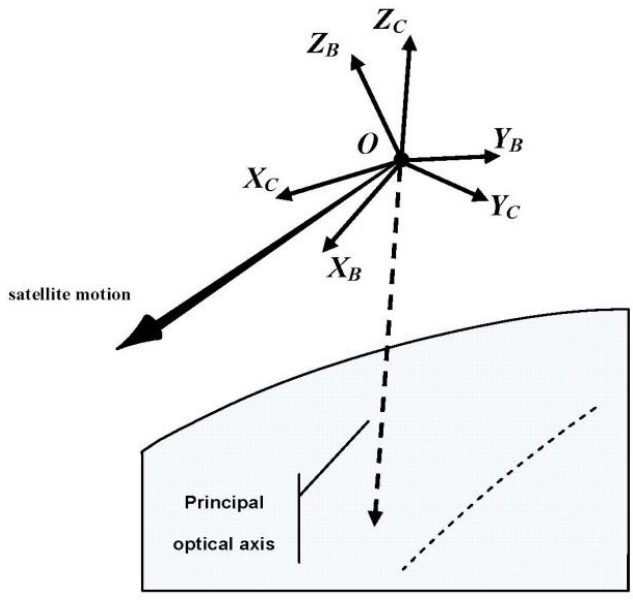
Figure 1. Camera’s coordinate system and satellite’s body-fixed coordinate